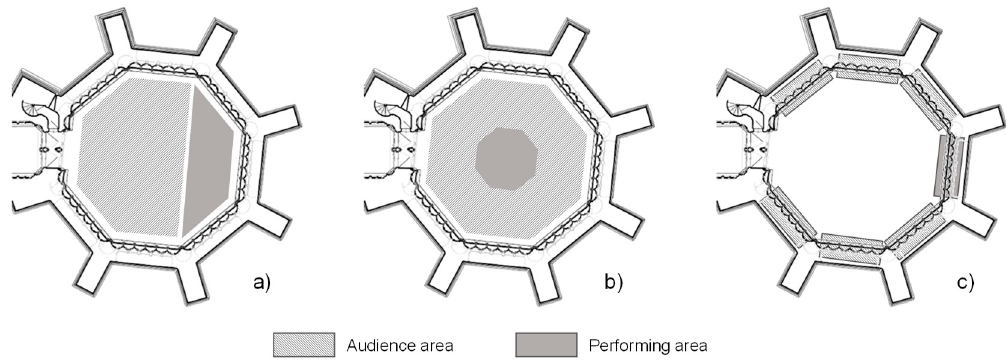
Figure 3. Examples of some typical configurations of the Chapter House: ( a ) front stage arrangement; ( b ) amphitheatre-like arrangement; and ( c ) original surrounding arrangement.